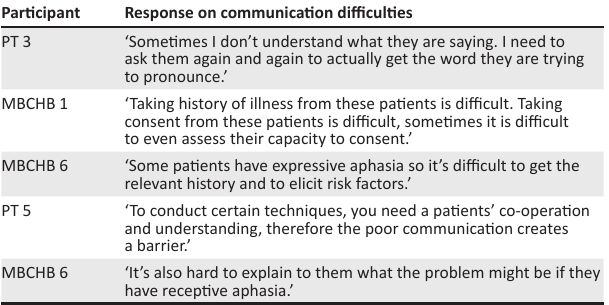
TABLE 1: Participants’ responses on the most common communication difficulties seen. Participant